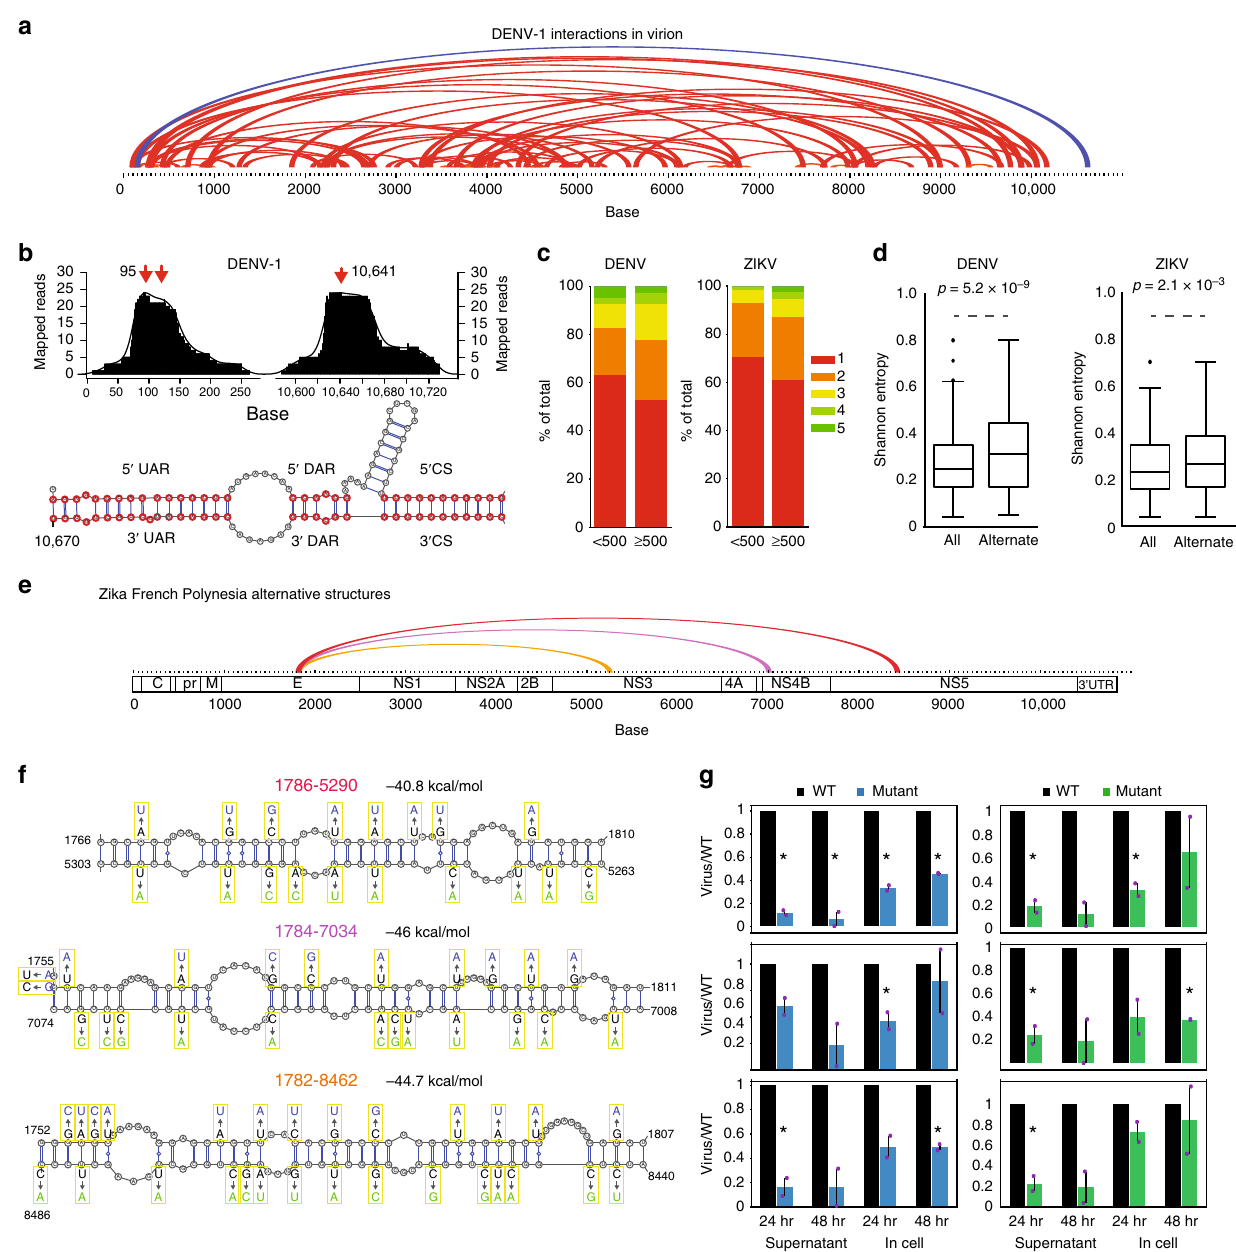
Fig. 3 DENV and ZIKV genomes form extensive pair-wise interactions. a Arc plot showing the most abundant top 75 pair-wise interactions in the DENV1 genome inside virions. The known circularization signal is colored in dark blue. b Top: peak calling of the circularization interaction region shows that the peak of base pairing occurs at positions 95 and 10,641. Bottom: prediction of hybridization using RNAcofold program using sequences around the called peaks identi fi ed three of the best known circularization signals. c Bar charts showing the number of peaks that interact uniquely and with other regions along the genome. Greater than forty percent of DENV and ZIKV interactions are not unique. d Boxplot showing that regions with alternative base pairing (alternate) have higher Shannon entropies than all regions present in the genome (all) for both DENV1 and ZIKV French Polynesia strain. Box encompasses fi rst and third quartiles, with the median indicated in the box. Whiskers are at minimum and maximum of points excluding deviations of 1.5× interquartile (Q3 – Q1) range from Q1 to Q3 as outliers. Outliers are indicated as dots. p -Value calculated using T -test. e Arc plot showing one set of alternative interactions found along the ZIKV French Polynesia genome. f Structure models of the pair-wise interactions for the alternative structures in e , using the program RNAcofold. Mutations along each strand of the pair-wise interaction are in blue and green respectively. g qPCR analysis of the amount of mutant (from f ) and WT virus that are produced in Huh7 cells and supernatant, 24 and 48 h post infection. The Y -axis shows that amount of mutant virus produced as compared to wild type. Statistical analysis was performed using Student ’ s T -test (one tail) to determine if the mutant viruses are attenuated compared to wild type. * p -value < 0.05. Error bars represent SEM. Two biological replicates of Gibson assembly were performed to generate WT and MT viruses and two biological replicates of Huh7 infection were